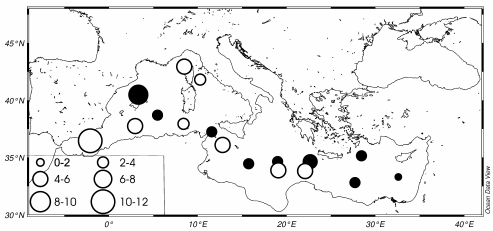
Fig. 17. Distribution of total mesozooplankton abundance (10 4 × ind. m − 2 ) in the 0–100m layer during June 1999 (black circles)(Source: Siokou-Frangou etal., 2004) and of total copepod abundance (10 4 × ind. m − 2 ) in the 0–200m layer during September 1999 (white circles) (reproduced with permission from Dolan et al., 2002).